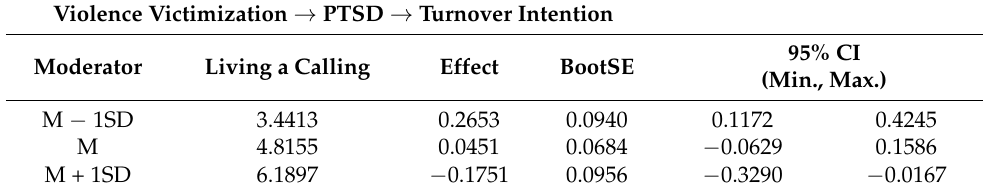
Table 5. Indirect effects of PTSD on turnover intention according to Living a